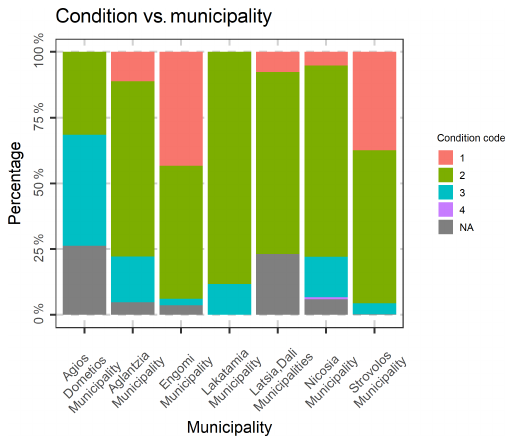
Figure 5. Percentage of condition code per